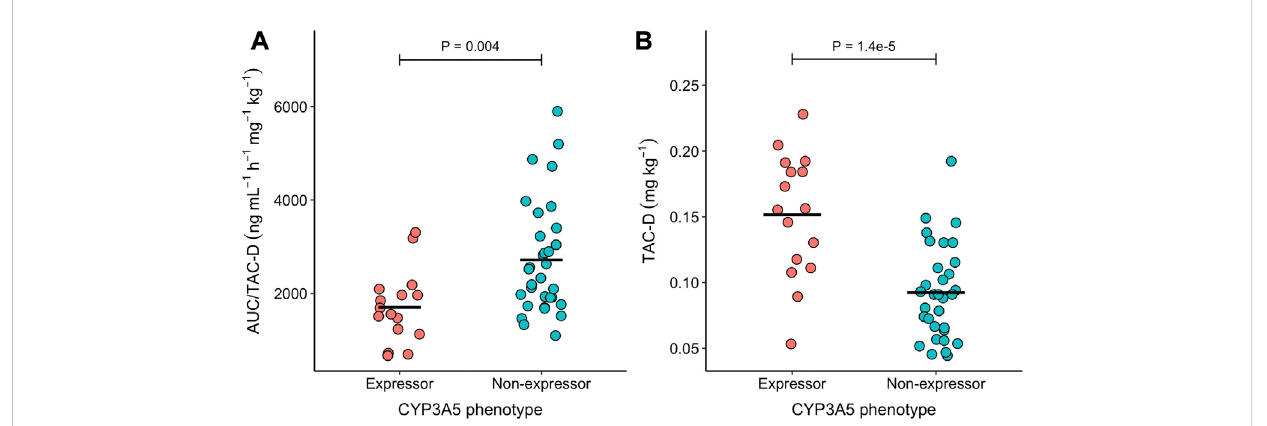
FIGURE 2 Scatterdotplotofthe (A) AUC(0 – 24)/TAC-Dand (B) TAC-DinthetwoCYP3A5expressiongroups.Horizontalblacklinesrepresentthemeanofeach group. Differences between expression groups were tested using a Mann Whitney U-test. P-value of these tests is indicated above the whiskers.